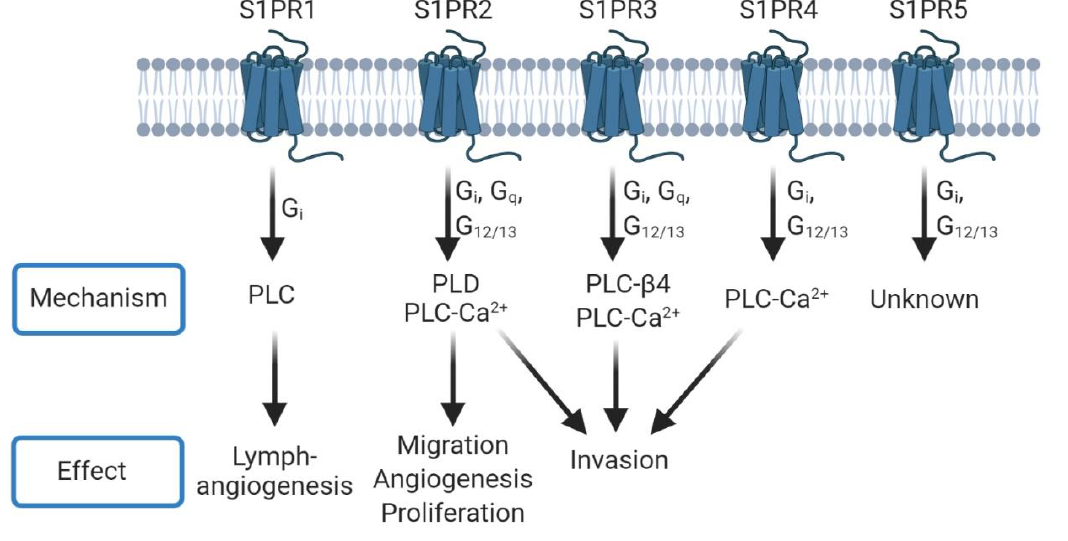
Figure 2. S1PRs can signal through phospholipase mechanisms. Each S1PR can couple to one or more G Protein-Coupled Receptors (GPCRs) to signal through different phospholipases and induce phenotypes such as angiogenesis, proliferation, and invasion. Many of these mechanisms overlap between receptors. Conversely, PLD signaling can lead to further production of S1P through the interaction of phosphatidic acid with sphingosine kinase 1 (SK1) [35].